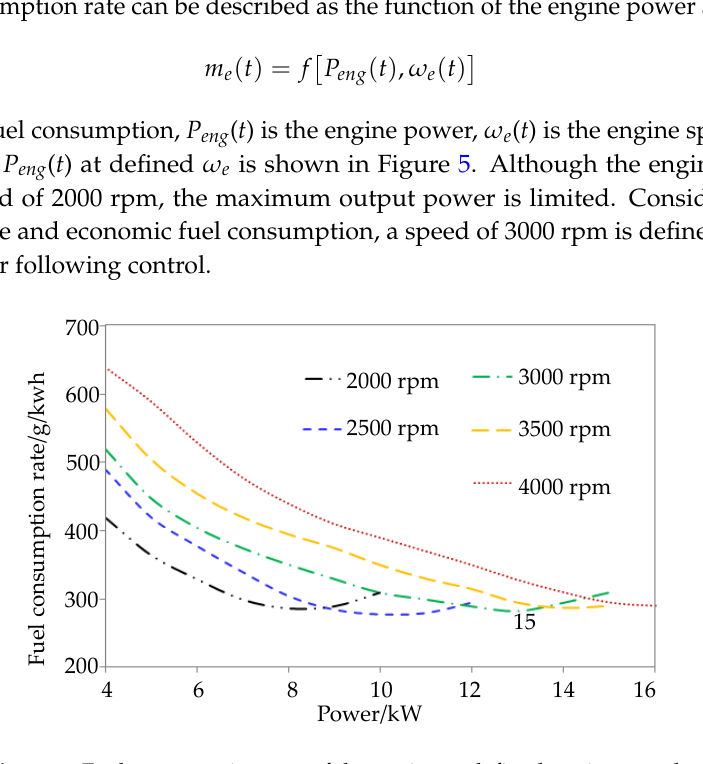
Figure 5. Fuel consumption rate of the engine at defined engine speeds.